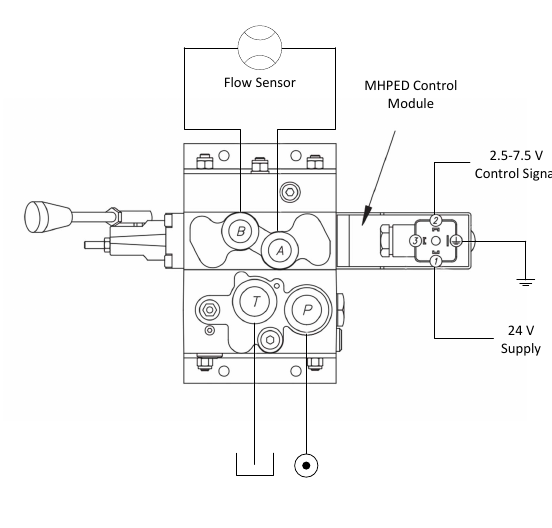
Figure 3: Schematic illustration of the hydraulic test